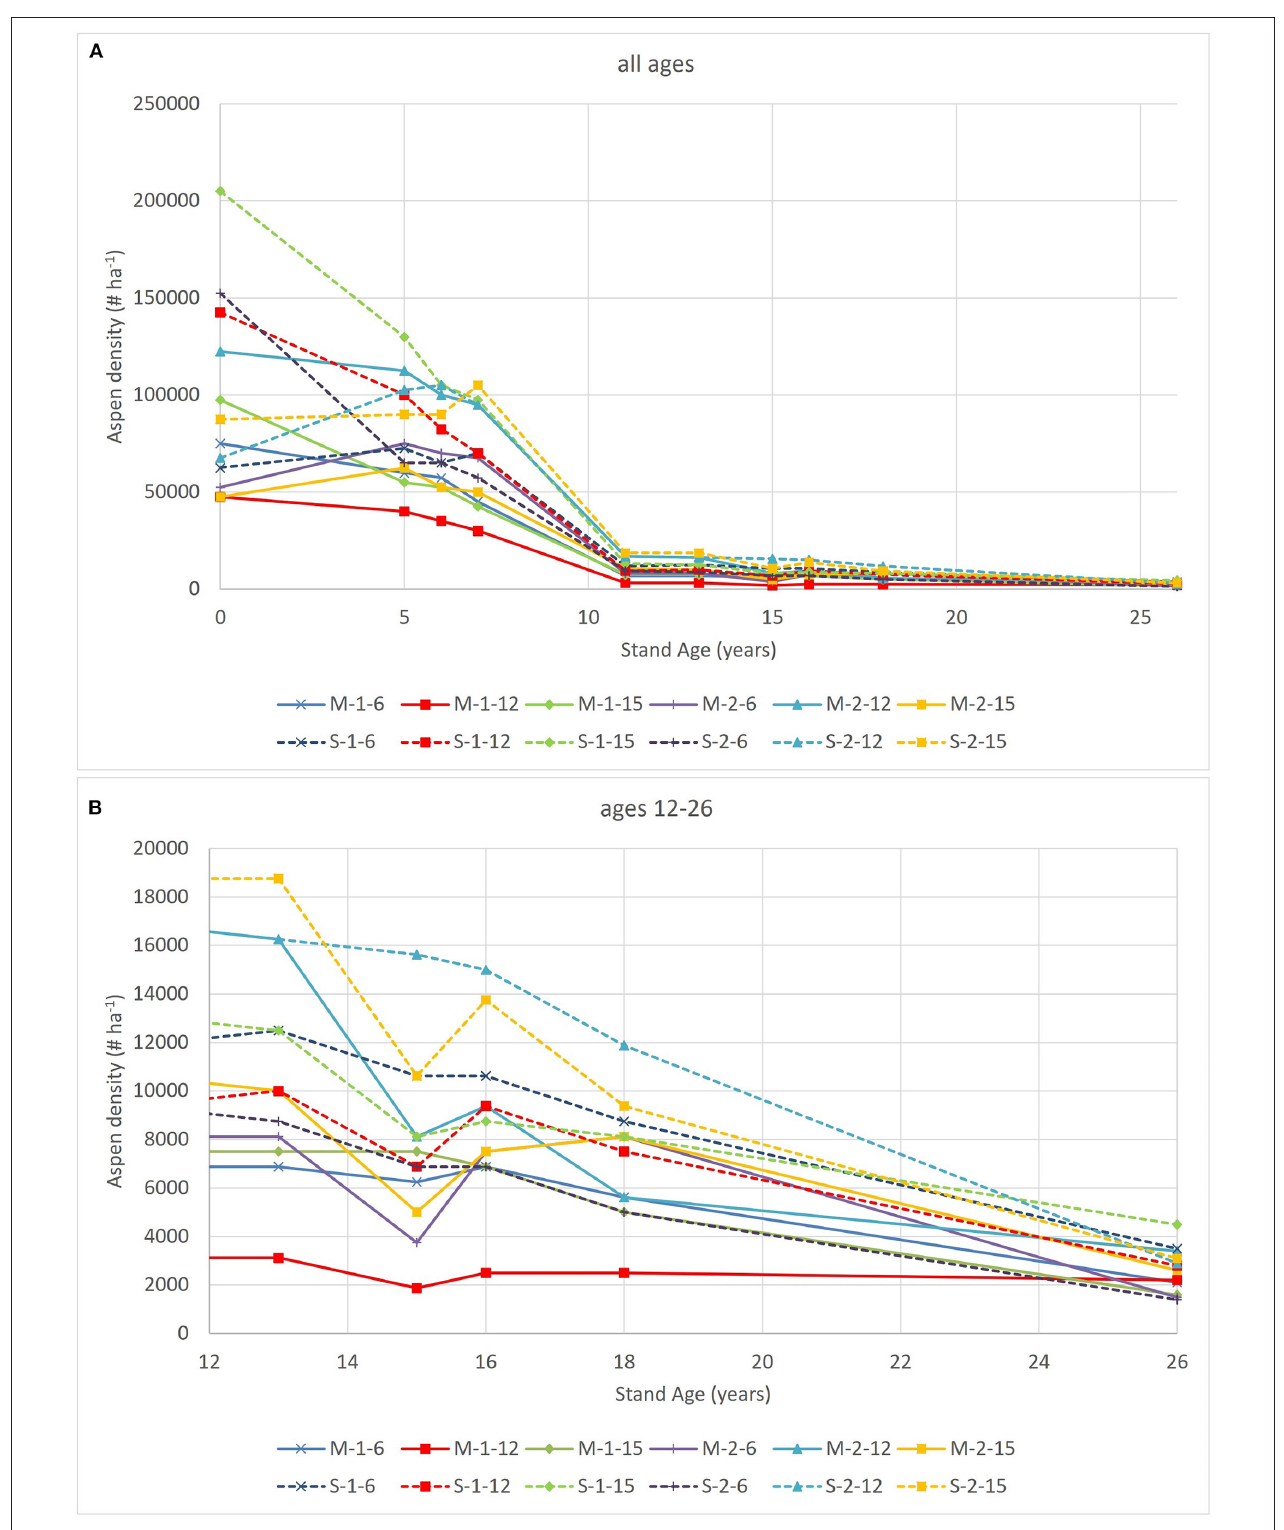
FIGURE 1 | Aspen density trends for the 12 unthinned plots. Panel (A) shows density trends across the full range of ages and panel (B) shows trends from ages 12 to 26. Plot labels refer to installation (M or S for median and superior, respectively), first number refers to replicate (1 or 2) and last number refers to plot number [6 (1,000 spruce ha − 1 ), 12 (500 spruce ha − 1 ) or 15 (0 spruce ha − 1 )].